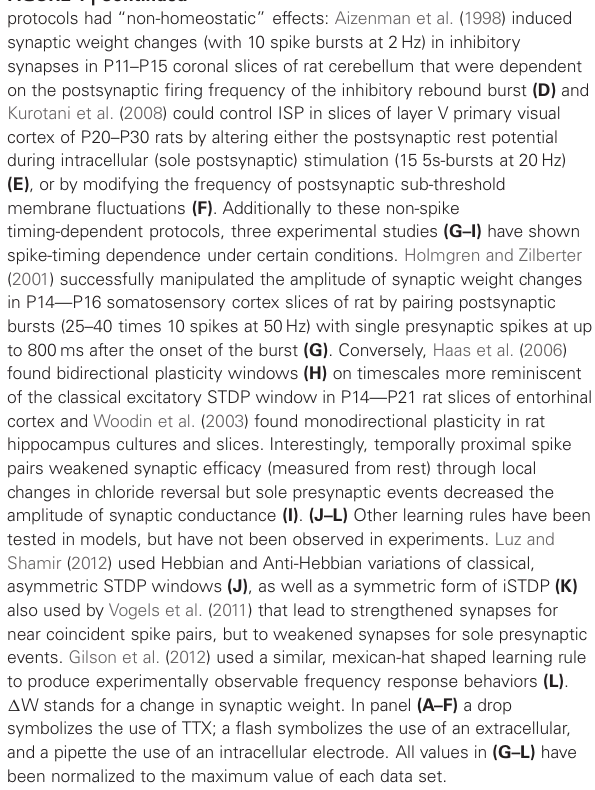
FIGURE 1 | Continued protocols had “non-homeostatic” effects: Aizenman et al. (1998) induced synaptic weight changes (with 10 spike bursts at 2Hz) in inhibitory synapses in P11–P15 coronal slices of rat cerebellum that were dependent on the postsynaptic firing frequency of the inhibitory rebound burst (D) and Kurotani et al. (2008) could control ISP in slices of layer V primary visual cortex of P20–P30 rats by altering either the postsynaptic rest potential during intracellular (sole postsynaptic) stimulation (15 5s-bursts at 20Hz) (E) , or by modifying the frequency of postsynaptic sub-threshold membrane fluctuations (F) . Additionally to these non-spike timing-dependent protocols, three experimental studies (G–I) have shown spike-timing dependence under certain conditions. Holmgren and Zilberter (2001) successfully manipulated the amplitude of synaptic weight changes in P14—P16 somatosensory cortex slices of rat by pairing postsynaptic bursts (25–40 times 10 spikes at 50Hz) with single presynaptic spikes at up to 800ms after the onset of the burst (G) . Conversely, Haas et al. (2006) found bidirectional plasticity windows (H) on timescales more reminiscent of the classical excitatory STDP window in P14—P21 rat slices of entorhinal cortex and Woodin et al. (2003) found monodirectional plasticity in rat hippocampus cultures and slices. Interestingly, temporally proximal spike pairs weakened synaptic efficacy (measured from rest) through local changes in chloride reversal but sole presynaptic events decreased the amplitude of synaptic conductance (I) . (J–L) Other learning rules have been tested in models, but have not been observed in experiments. Luz and Shamir (2012) used Hebbian and Anti-Hebbian variations of classical, asymmetric STDP windows (J) , as well as a symmetric form of iSTDP (K) also used by Vogels et al. (2011) that lead to strengthened synapses for near coincident spike pairs, but to weakened synapses for sole